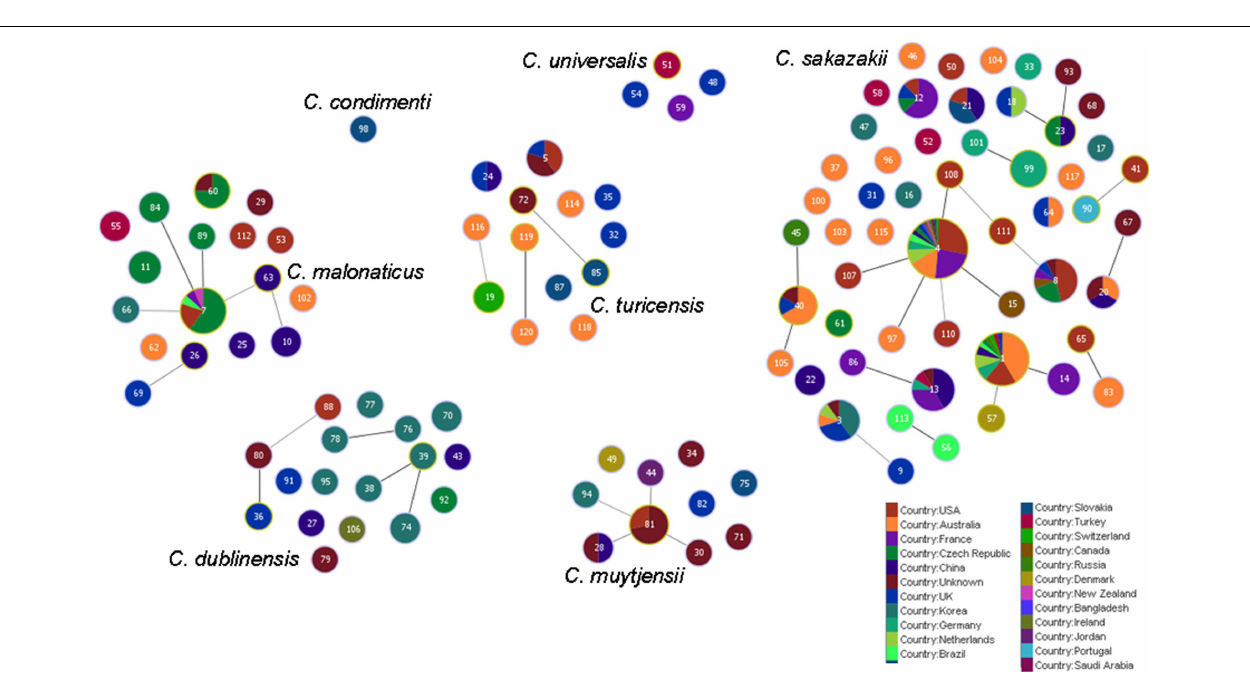
FIGURE 6 | Population snapshot of the Cronobacter MLST database generated using goeBURST, indicating the clonal complexes and the diversity of the strains based on country of isolation. The threshold for the output was set to triple locus variation.The dominant STs are represented by the circles with larger